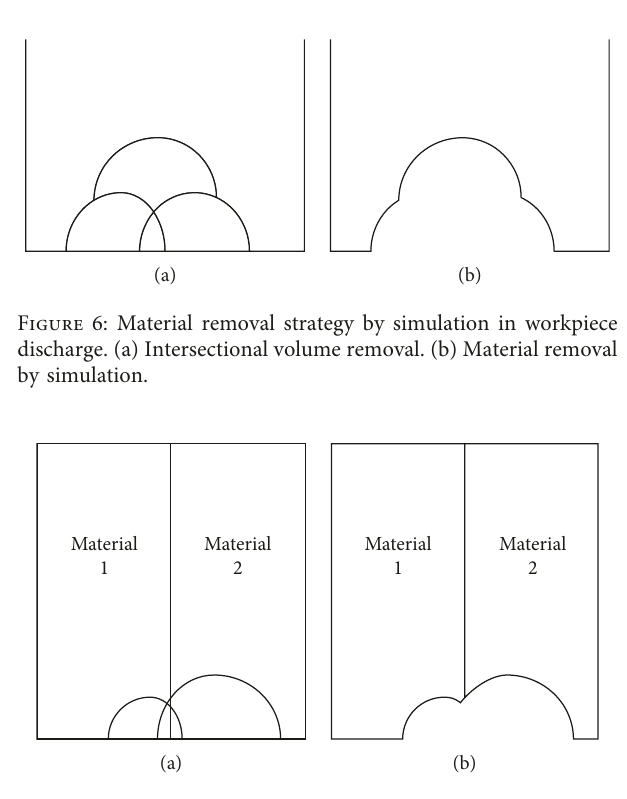
Figure 7: Material removal strategy by simulation in multimaterial electrode discharge. (a) Intersectional volume removal. (b) Material removal by simulation.